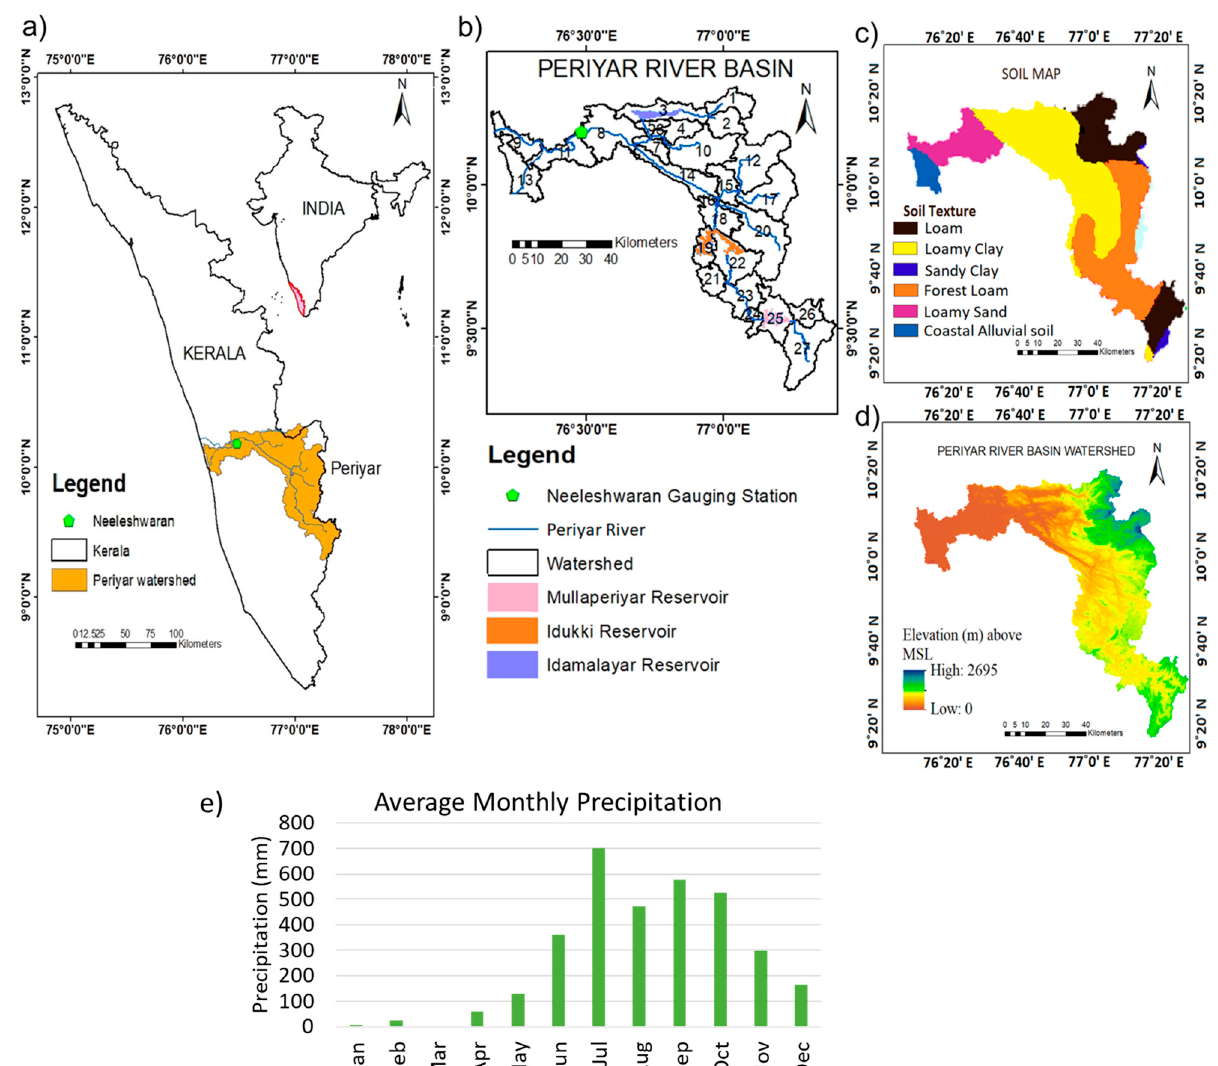
Figure 1. ( a ) Location, ( b ) delineated sub-watersheds (with sub-watersheds numbered from 1 to 27), ( c ) soil texture, ( d ) elevation map, and ( e ) average monthly precipitation (1991–2004) for PRW.